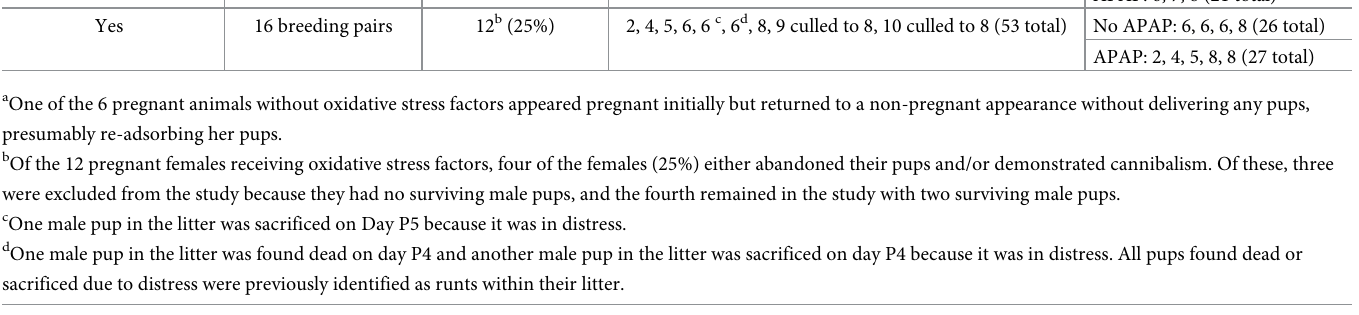
Fig 2. Precision of microinjections. The results of a total of 800 injections of sterile water with a Microdose TM microinjector are shown. The injector was set at 10 uL for all injections, and volume was determined by weighing the solution using a Mettler balance and assuming a solution density of 1.00g/ml. One unit was dispensed for 400 injections, and two units (20 uL total) were dispensed for the other 400 injections. The single injections (expected volume of 10 uL) had a standard deviation of 0.83 uL with a coefficient of variation of 8.5%. The double injections (expected volume of 20 uL) had a standard deviation of 0.80 uL with a coefficient of variation of 4.1%.